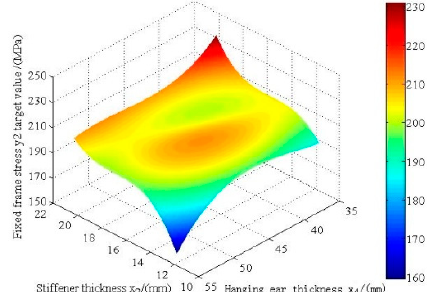
Figure 16. Three-dimensional response model with x 2 and x 4 .